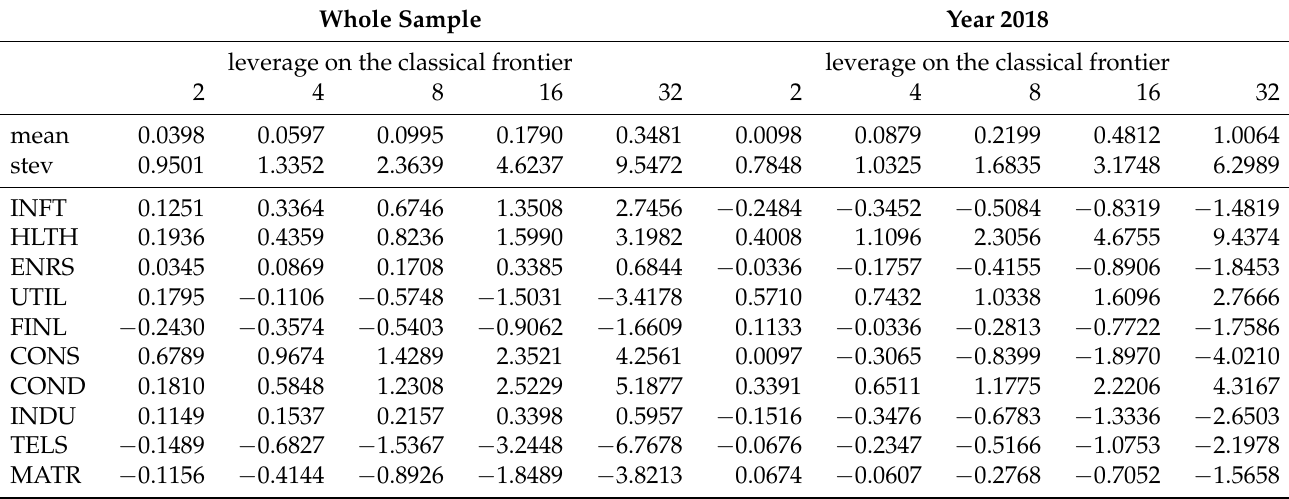
Figure 4. Unleveraged equivalent sets obtained from portfolios on the S&P sectors, based on the data of one year periods. Four years are shown. The arrows head to the increase of leverage. The labels indicate the leverage levels of the corresponding leveraged portfolio on the classical frontier. Table 2. Portfolios weights for some given leverage